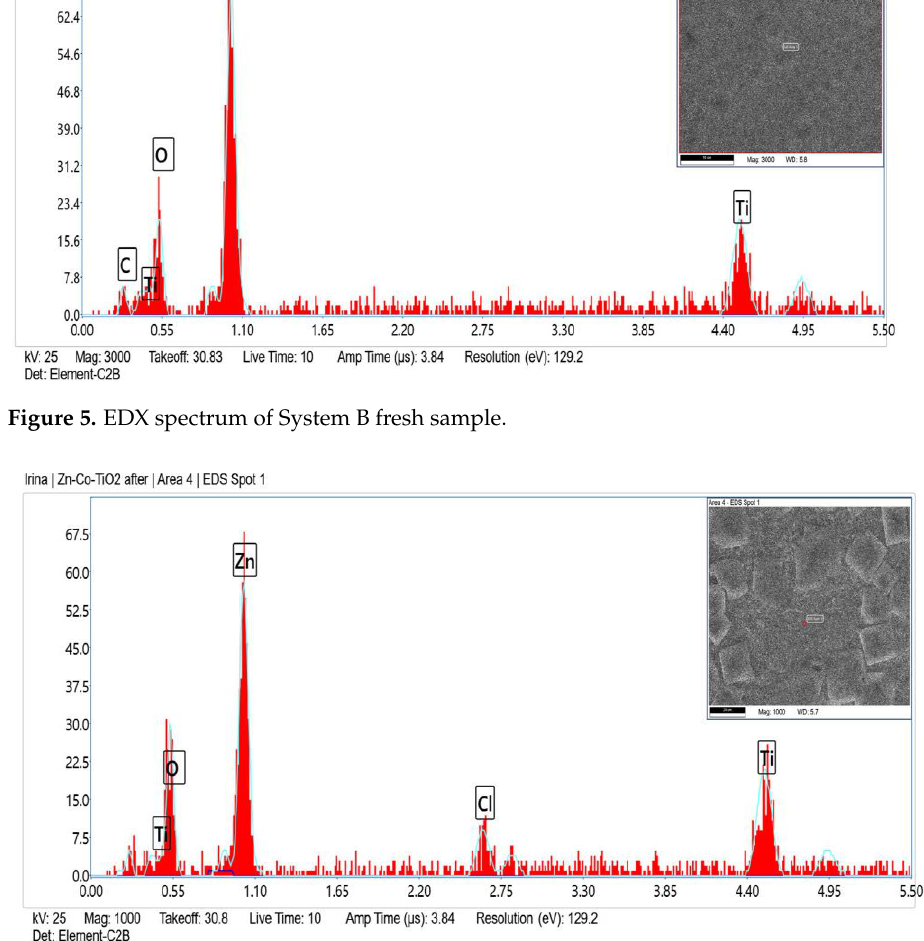
Figure 6. EDX spectrum of System B after corrosive attack.